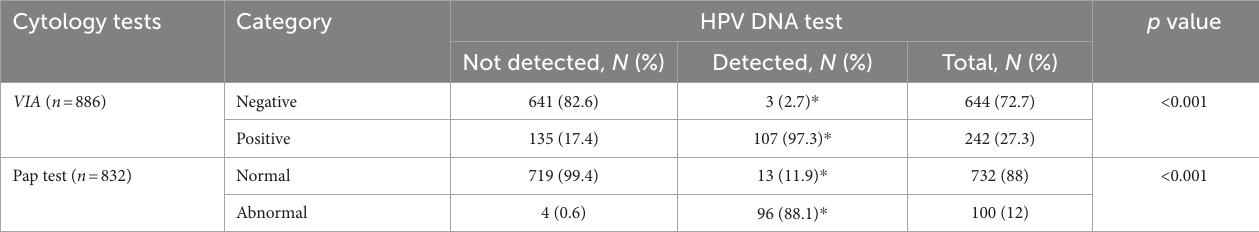
TABLE 2 Prevalence of hr HPV infection based on cytology outcome among Ethiopian women. Cytology